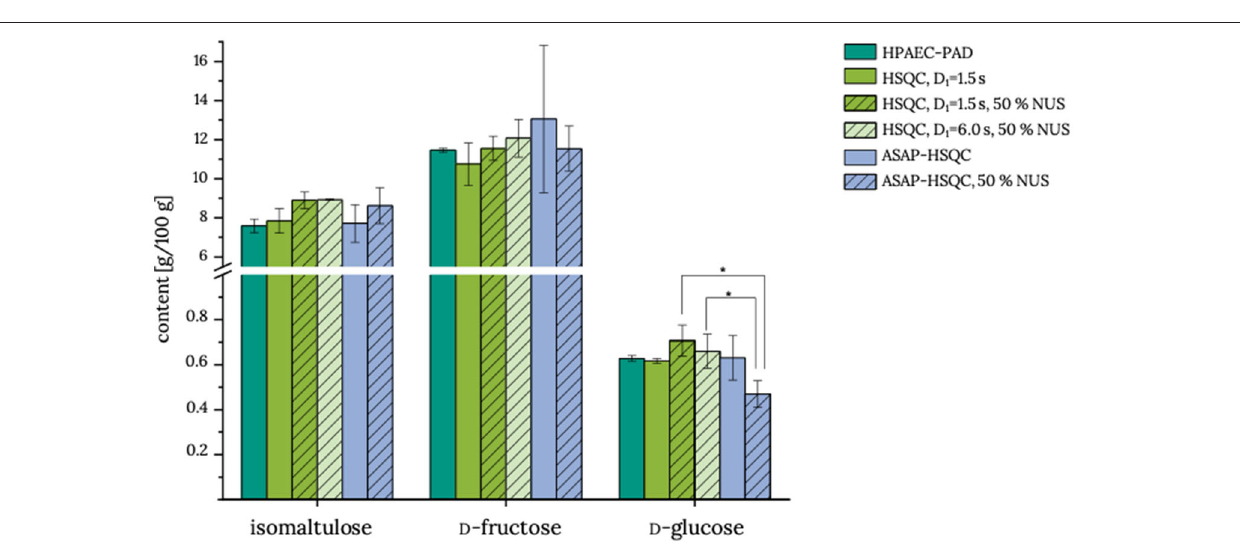
Frontiers in Nutrition |